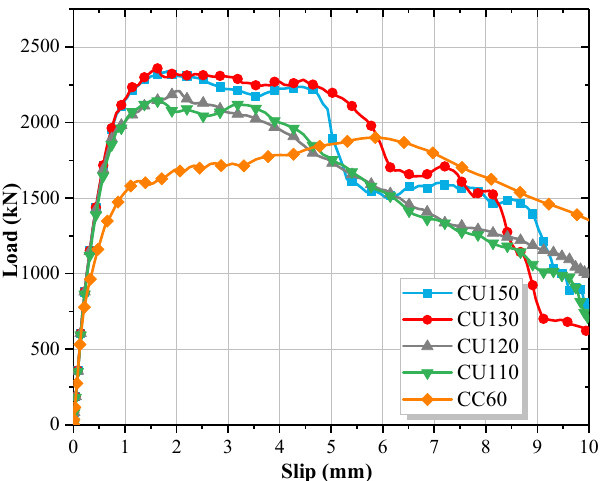
Figure 26. Load-slip curves of specimens with different compressive strength of connection concrete.